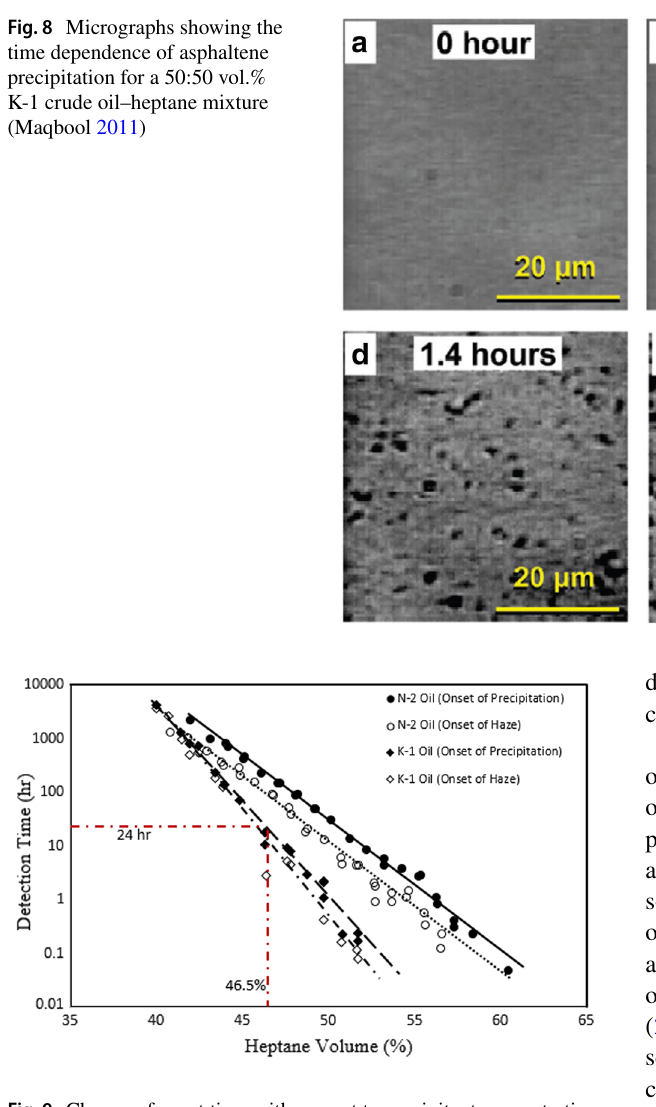
Fig. 9 Change of onset time with respect to precipitant concentration, detected using optical microscopy technique at ambient conditions (Maqbool